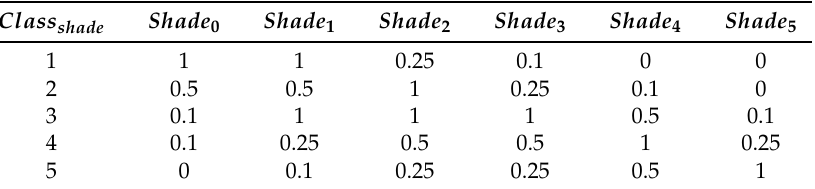
Table A25. NECN light establishment parameters.